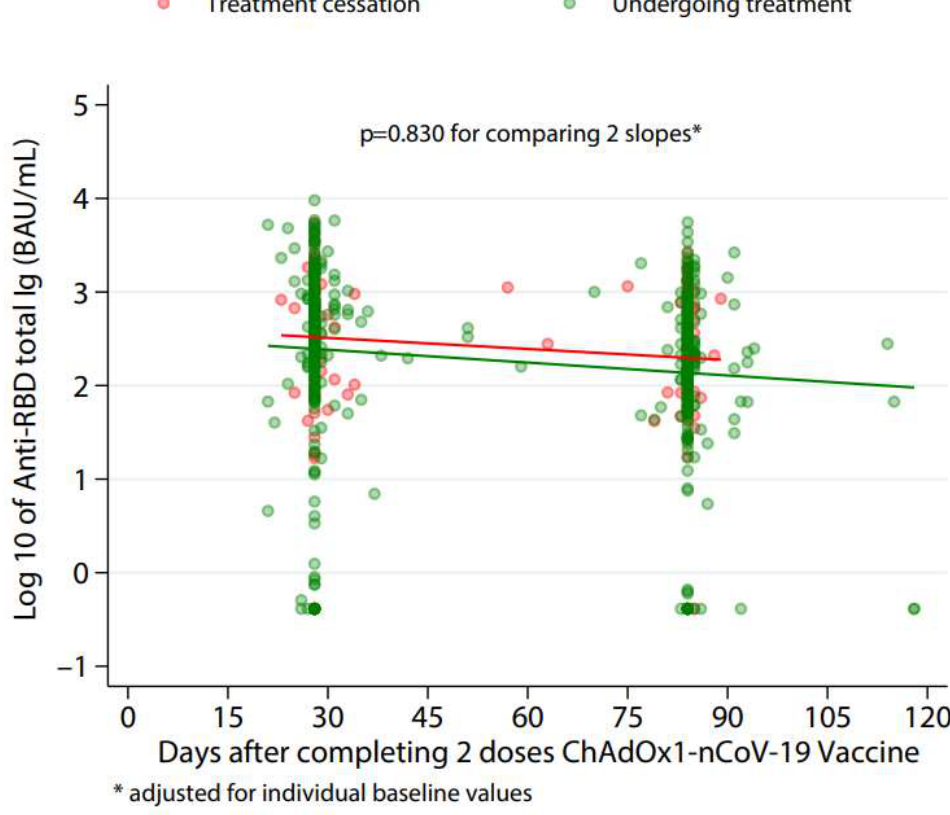
Figure 4. Effect of treatment cessation on antibody response. The SARS-CoV-2 binding antibody levels at 1 and 3 months after two doses of the ChAdOx-nCoV-19 vaccine in cancer treatment cessation patients (n = 63, red color), and those undergoing anticancer treatment (n = 227, green color) ( A ). Dynamics ( B ) and slopes ( C ) of anti-RBD total Ig at 1 month and 3 months after the second dose of ChAdOx1-nCoV-19 among cancer patients who discontinued treatment compared to those receiving anticancer treatment—adjusted for individual baseline values (at 1 month). Slopes of regression lines adjusted for individual baseline values (at 1 month): slope (treatment interruption) = − 0.003885 (log 10 scale)/day, slope (no interruption) = − 0.004224 (log 10 scale)/day.